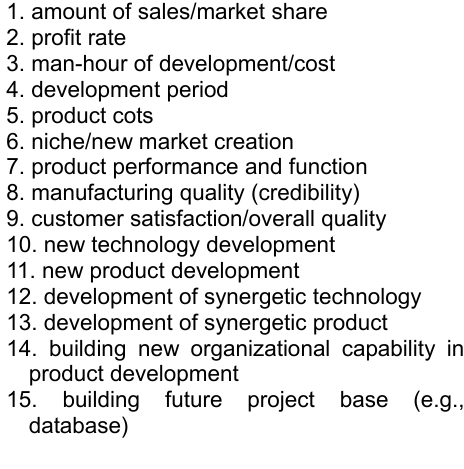
Table 1. Items of Project